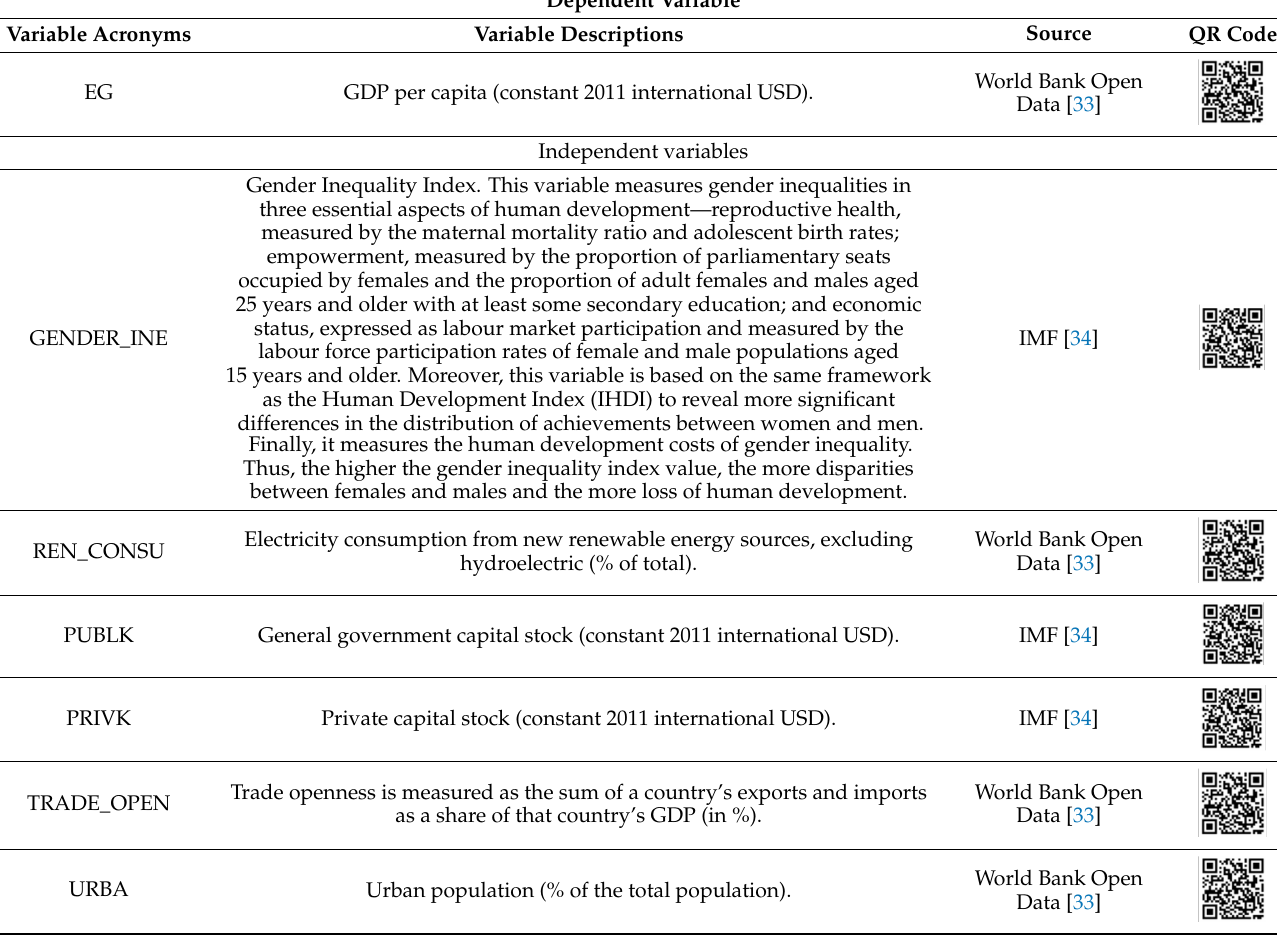
Table 1. Variable acronyms, descriptions, and